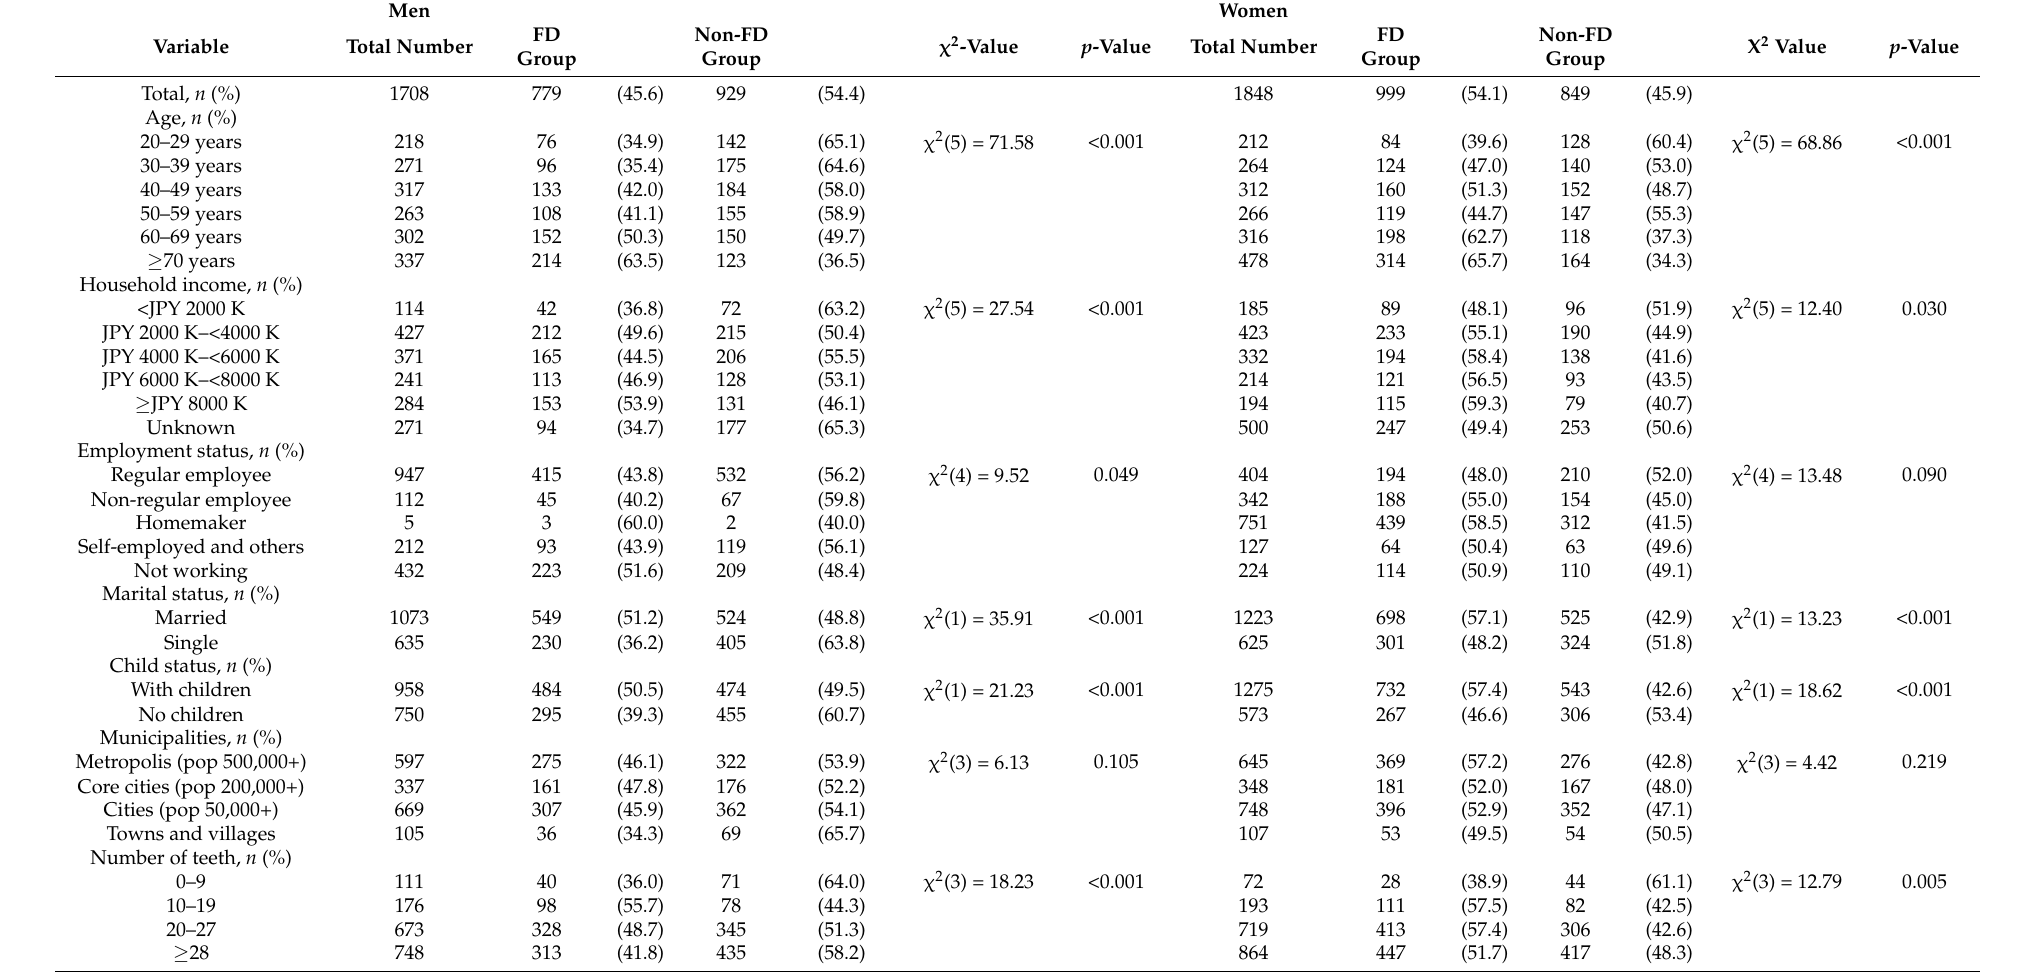
Table 2. Relationship between belonging to the FD or non-FD group and the characteristics of the